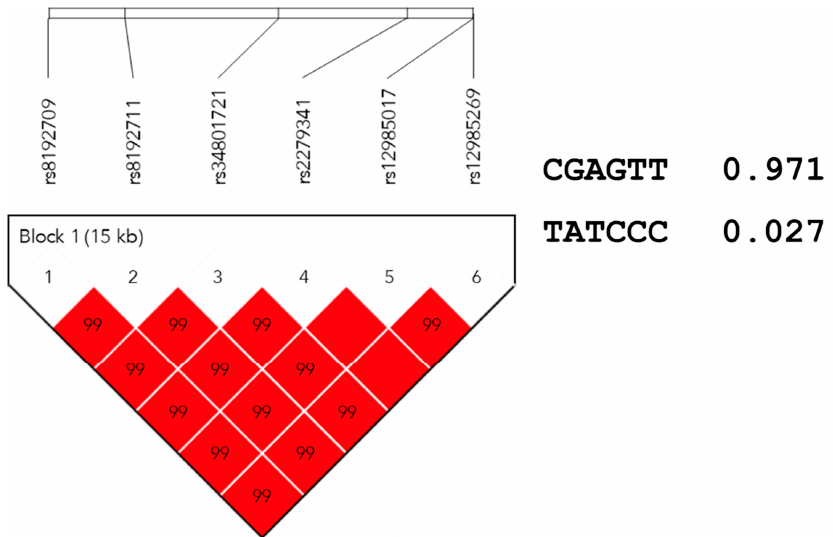
Figure 2. Haplotype block map constructed by candidate single-nucleotide variations in CYP2B6 . Notes: Block 1 includes rs8192709, rs8192711, rs34801721, rs2279341, rs12985017, and rs12985269; the linkage disequilibrium between two SNPs is indicated by the standardized r 2 (red boxes).